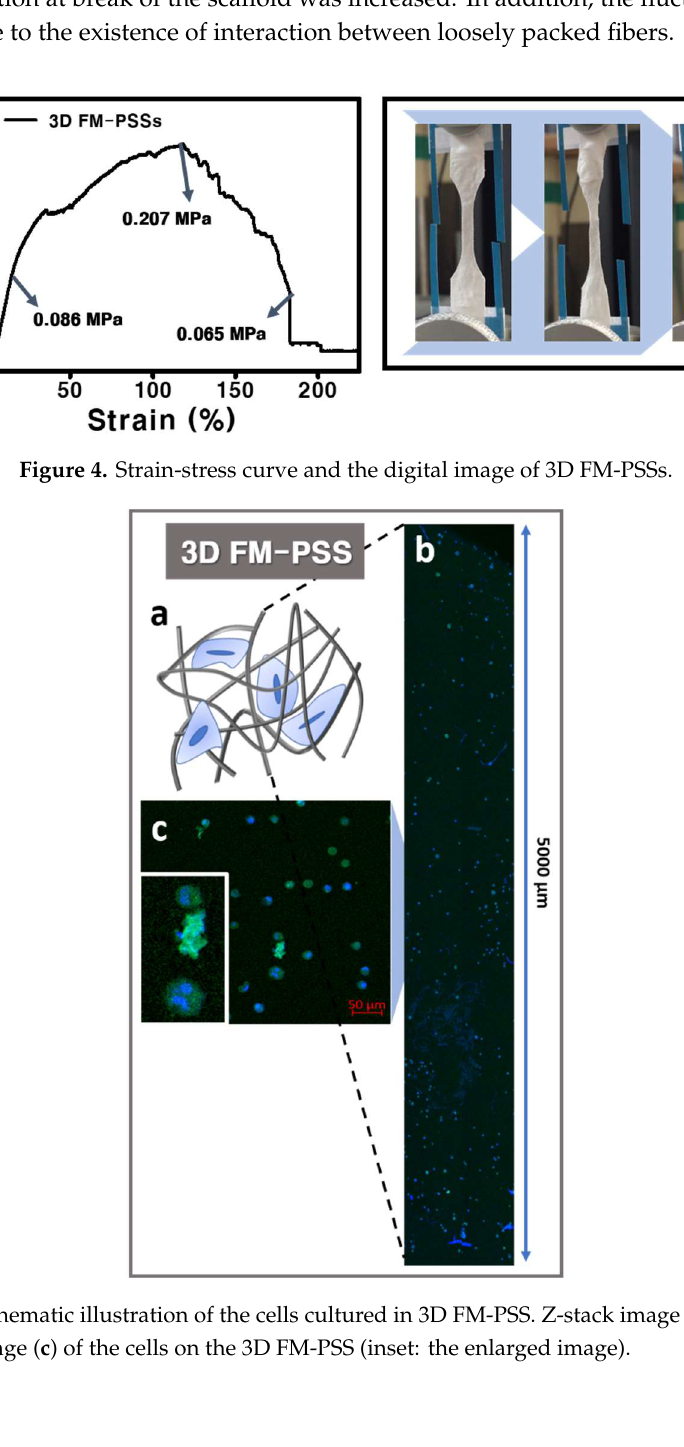
Figure 5. ( a ) Schematic illustration of the cells cultured in 3D FM-PSS. Z-stack image ( b ) and confocal microscopy image ( c ) of the cells on the 3D FM-PSS (inset: the enlarged image).